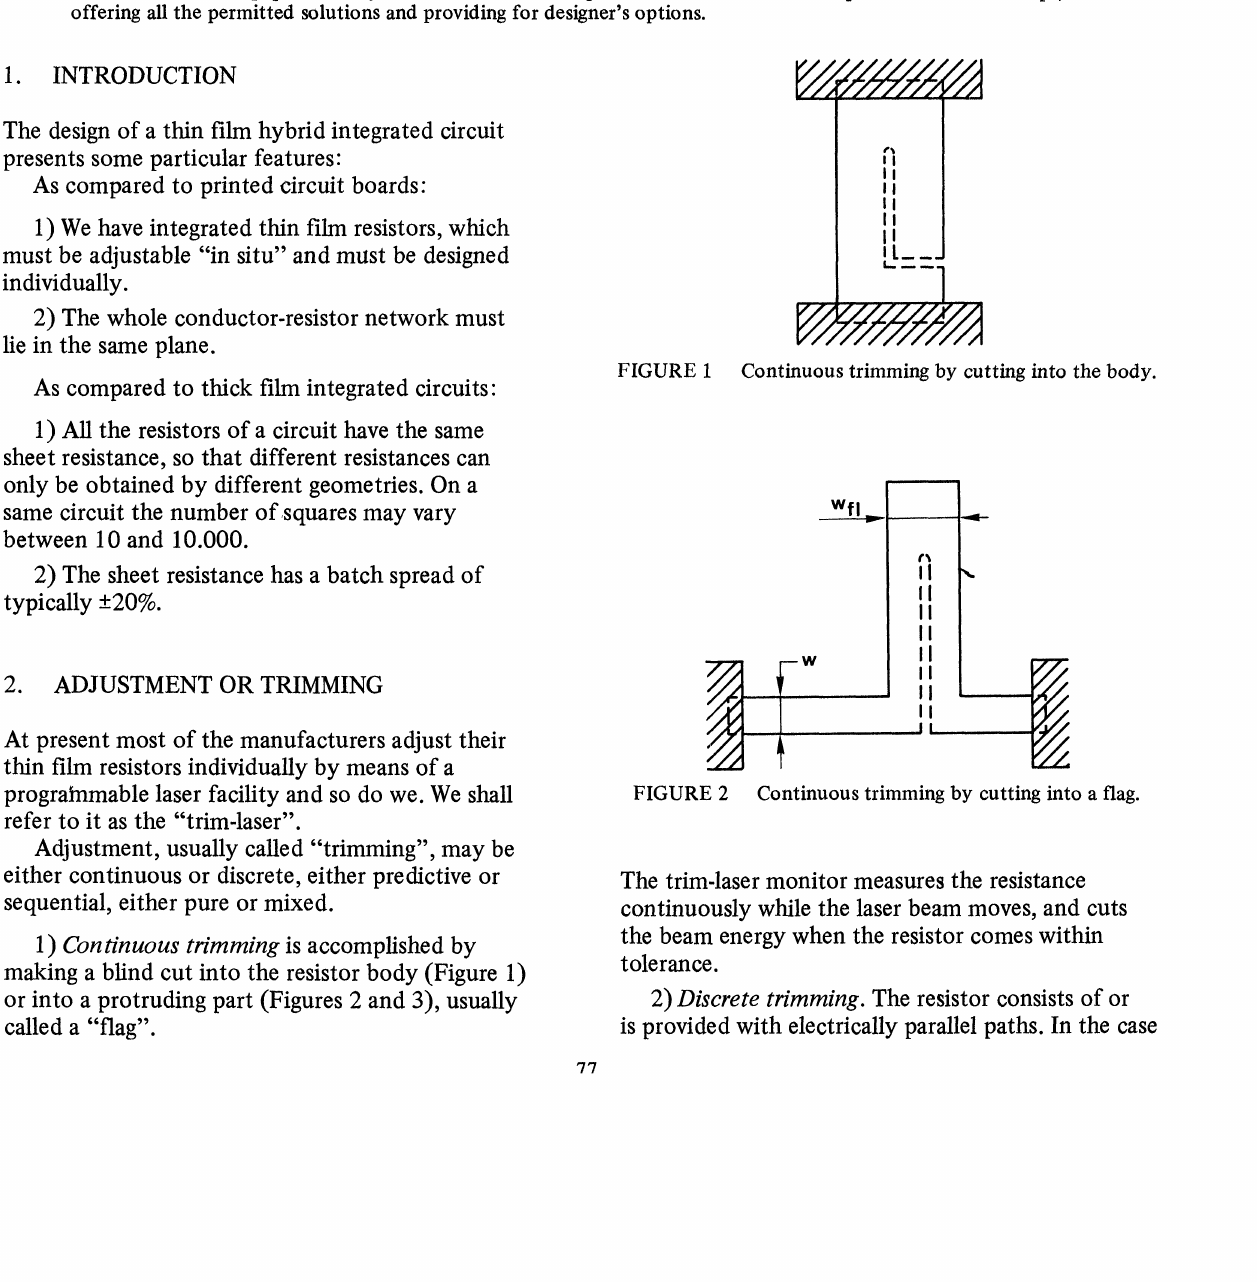
Continuous trimming by cutting into a flag. FIGURE